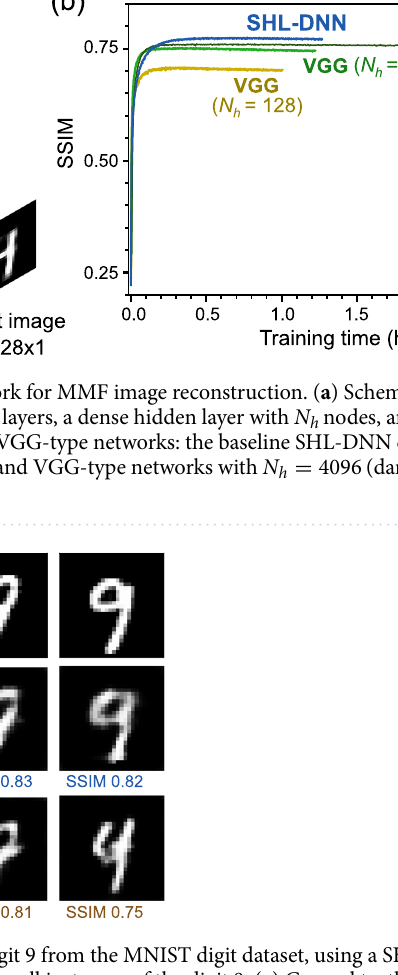
Figure 6. Reconstruction of images of the digit 9 from the MNIST digit dataset, using a SHL-DNN trained with a modified MNIST digit dataset excluding all instances of the digit 9. ( a ) Ground truth images. ( b ) Reconstructed images of digit ’9’ by the SHL-DNN trained with the modified dataset. ( c ) Reconstructed images of digit ’9’ by the U-net trained with the modified dataset. SSIM scores are shown below the reconstructed